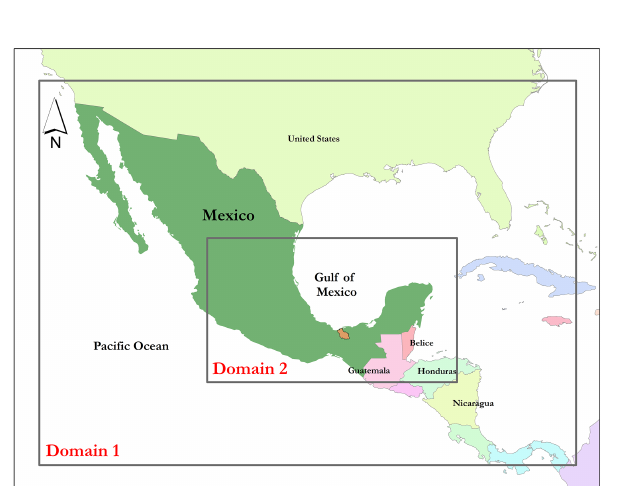
Figure 2. Numerical setup of the WRF with a nested domain cov- ering Mexico. Domain 1: 25km resolution; Domain 2: 4km resolu- tion; the orange region illustrates the Tonalá